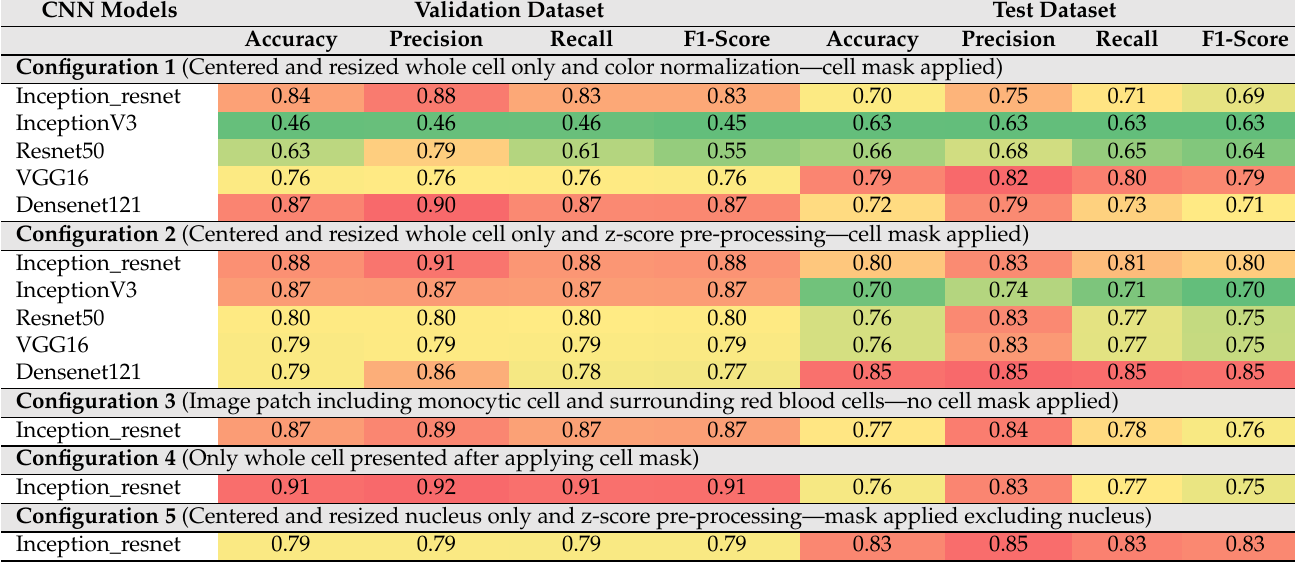
Table 2. Performance of CNN models using five pre-processing configurations on 2-subcategory (monocytes and promono- cytes + blasts) classification